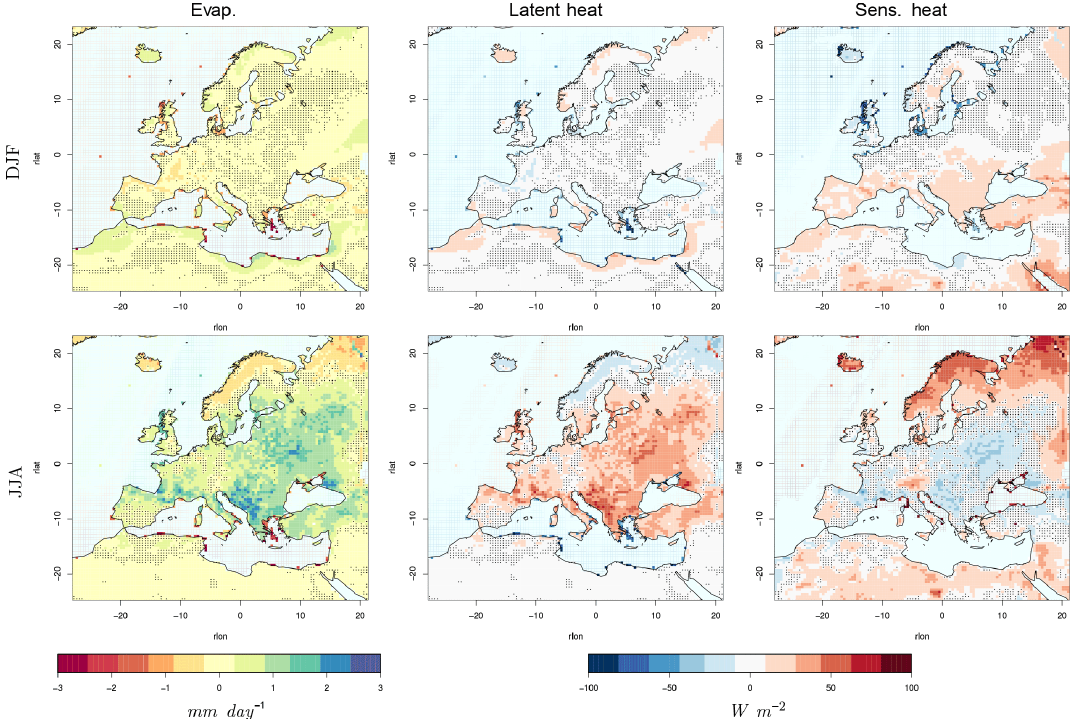
Figure 5. Biases of seasonal means of Evapotranspiration (left), Latent (centre) and Sensible Heat (right) fluxes, between the CCLM sim- ulations and the GLDAS data set, calculated for the reference period 1991–2000. As in the previous figures, the area with a point represent the grid cells where the anomalies between the two data sets are not significant, according to a Student’s t test, at a significance level of 5%. Winter results are presented in the first row, and Summer results in the